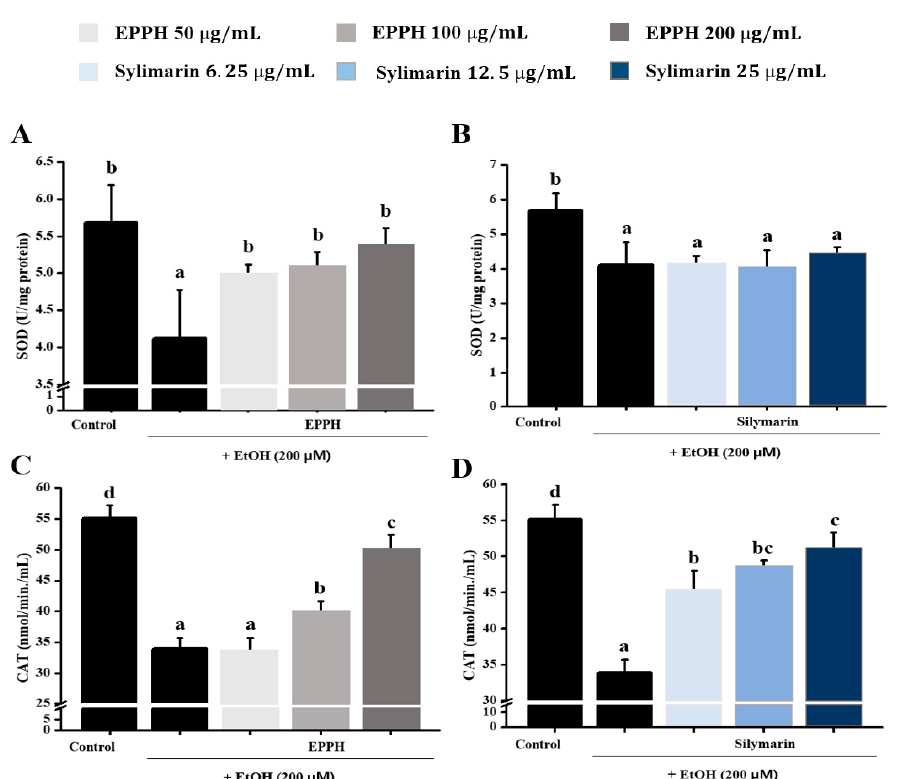
Figure 1. Effect of EPPH extract on EtOH-induced antioxidant enzymes on HepG2 cells. SOD activity with ( A ) EPPH and ( B ) silymarin. CAT activity with ( C ) EPPH and ( D ) silymarin. The data are expressed as the mean ± SD ( n = 3), and different letters (d > c > b > a) indicate a significant difference at p < 0.05, as determined by Duncan’s multiple-range test.